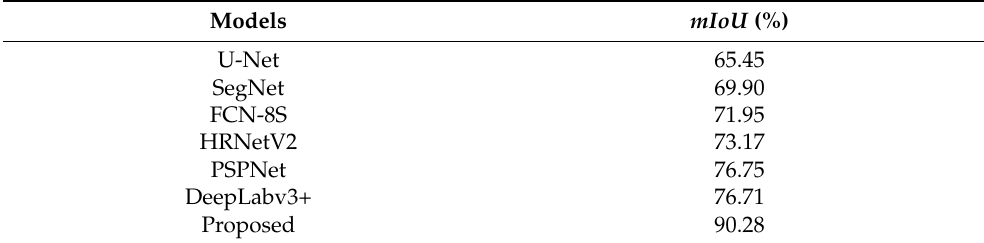
Table 3. A comparison of mIoU with different